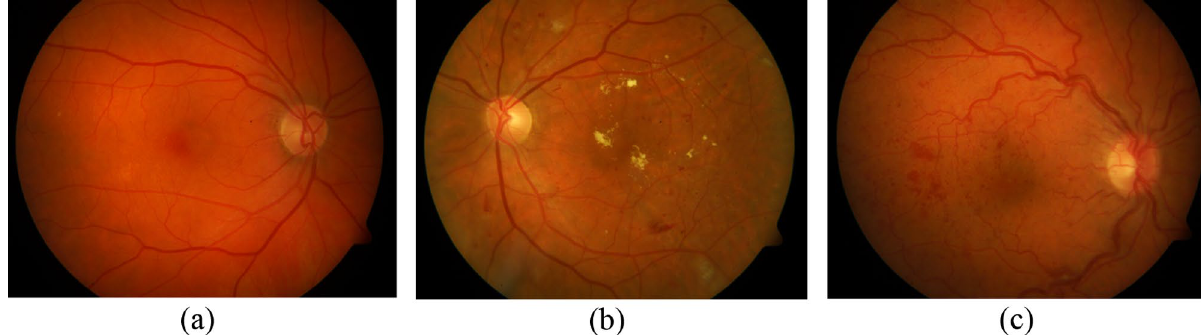
Figure 1. Stages of diabetic retinopathy in fundus images ( a ) Normal image ( b ) NPDR ( c )